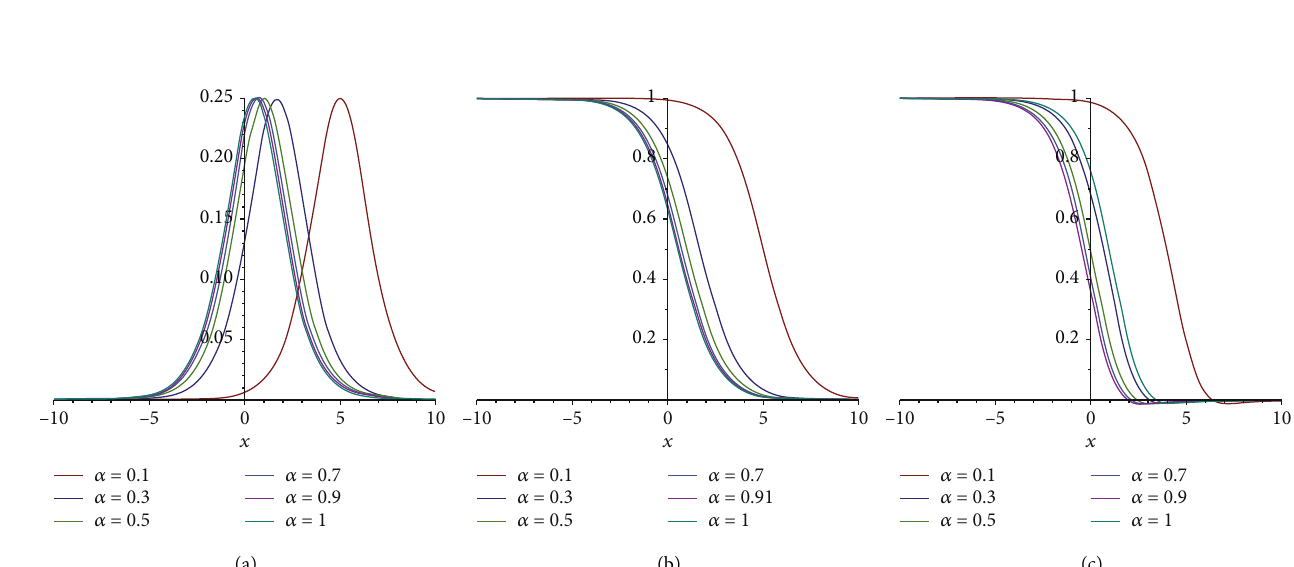
= τ = c = 1 and t = 1for different valuesof α 1 2